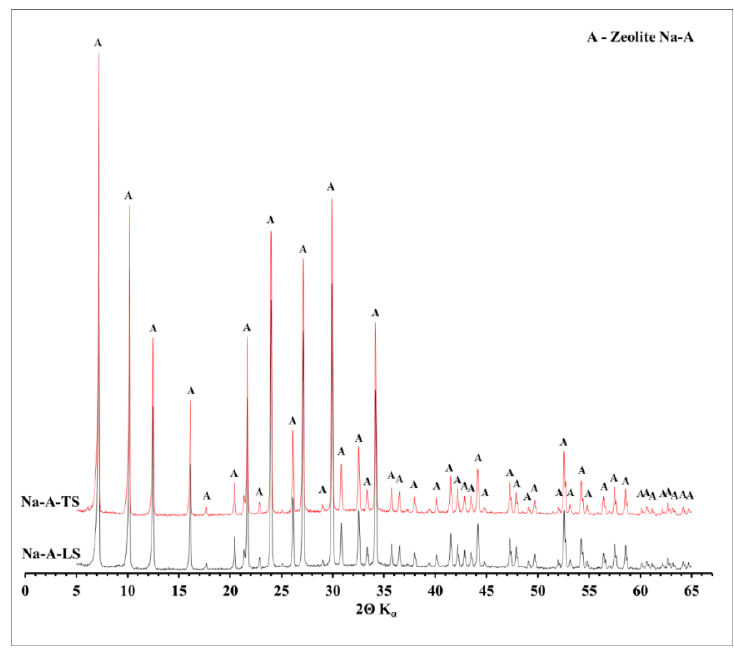
Figure 3. Mineral phase composition of Na-A-LS and Na-A-TS zeolites.